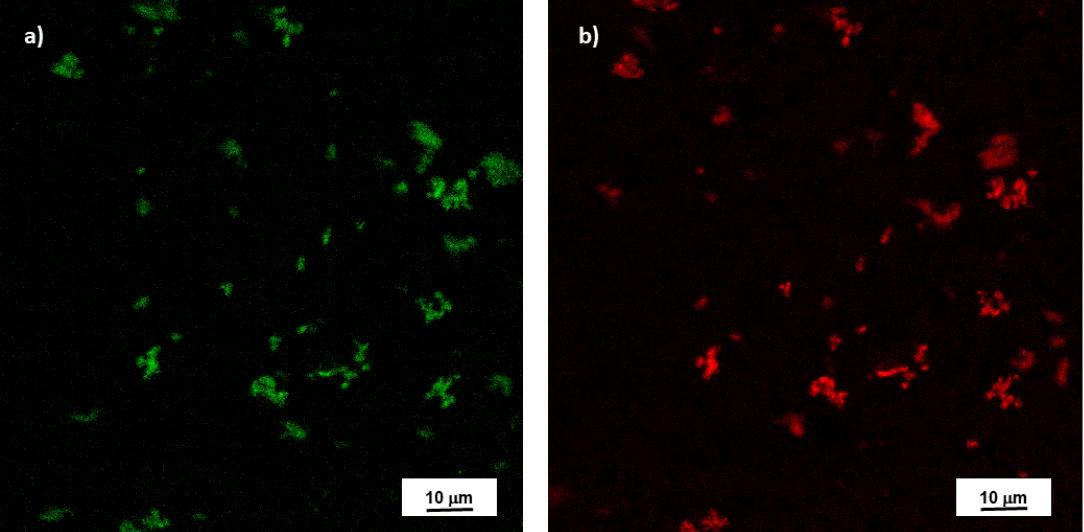
Figure 5. Representative fluorescence of label-free NPs visualized by the Argon 488 nm ( a ) and Elio-Neon 543 nm ( b ) laser lines of a C1 NIKON confocal laser scanning unit coupled to a NIKON TE300 microscope with a 100X/1.30 oil objective.